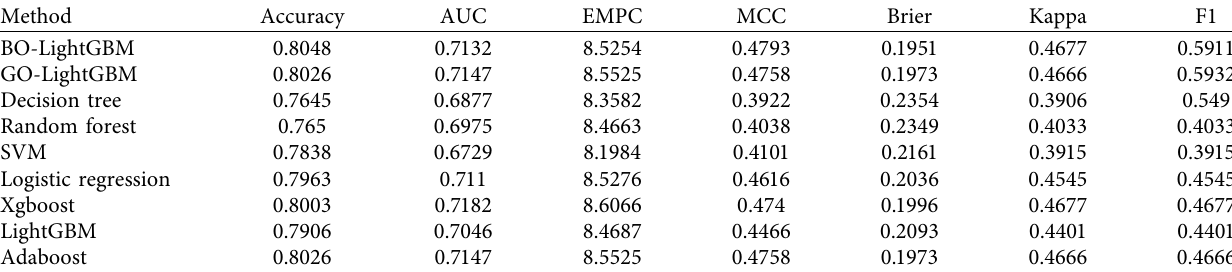
Table 11: Evaluation result of IBM dataset.